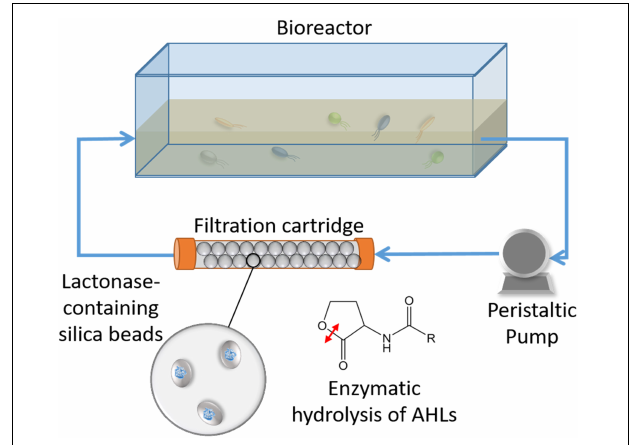
FIGURE 1 | Schematic representation of the experimental system. Bacterial communities are cultured in a tank vessel. A peristaltic pump is pumping the culture media through a filtration cartridge made of silica beads. The beads are entrapping E. coli cells that overproduced an engineered quorum quenching lactonase. As the system operates, the N -acyl homoserine lactone molecules (AHLs) produced by cultured bacteria are enzymatically degraded by the filtration